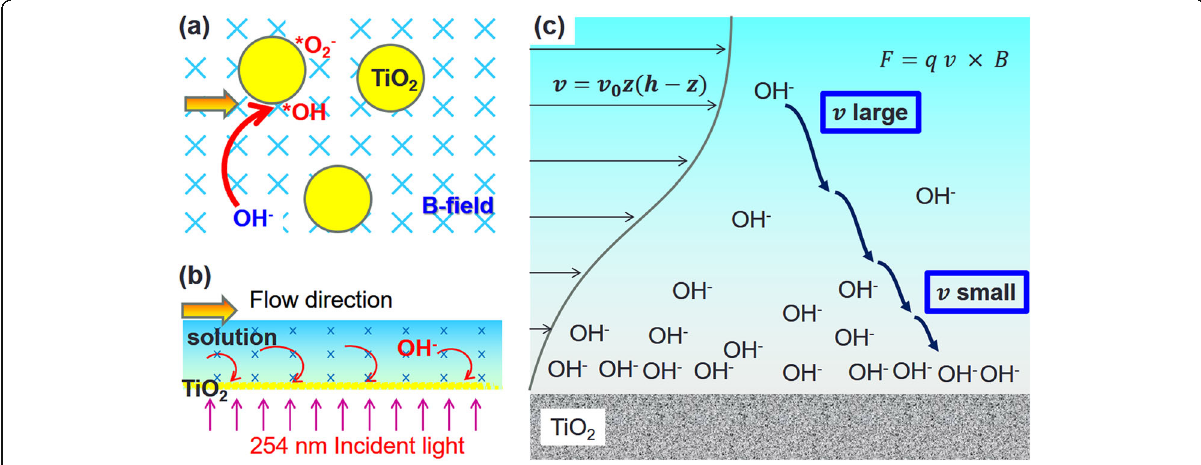
Fig. 6 a Photocatalytic degradation of MO under various magnetic fields with and without EA. b Effects of flow speed in the magnetic field- enhanced photocatalytic reaction in the micro optofluidic chip reactor. c . Effect of ion-condensation of OH in